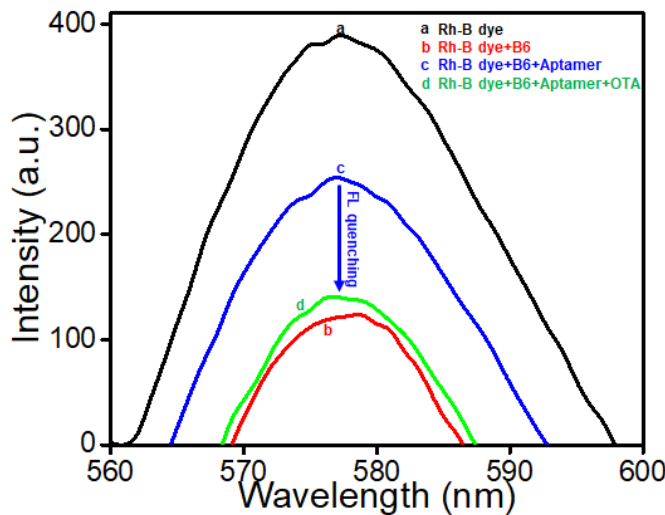
Figure 6. Fluorescence emission spectra of Rh-B (160 ng/L) ( a ); quenched fluorescence emission with ZnSe-B6 nanoquencher of 450 µg/L ( b ); fluorescence recovery with OTA aptamer (50 nM) stabilized with (450 µg/L) ZnSe-B6 ( c ); fluorescence quenching recovery with OTA ( d ).